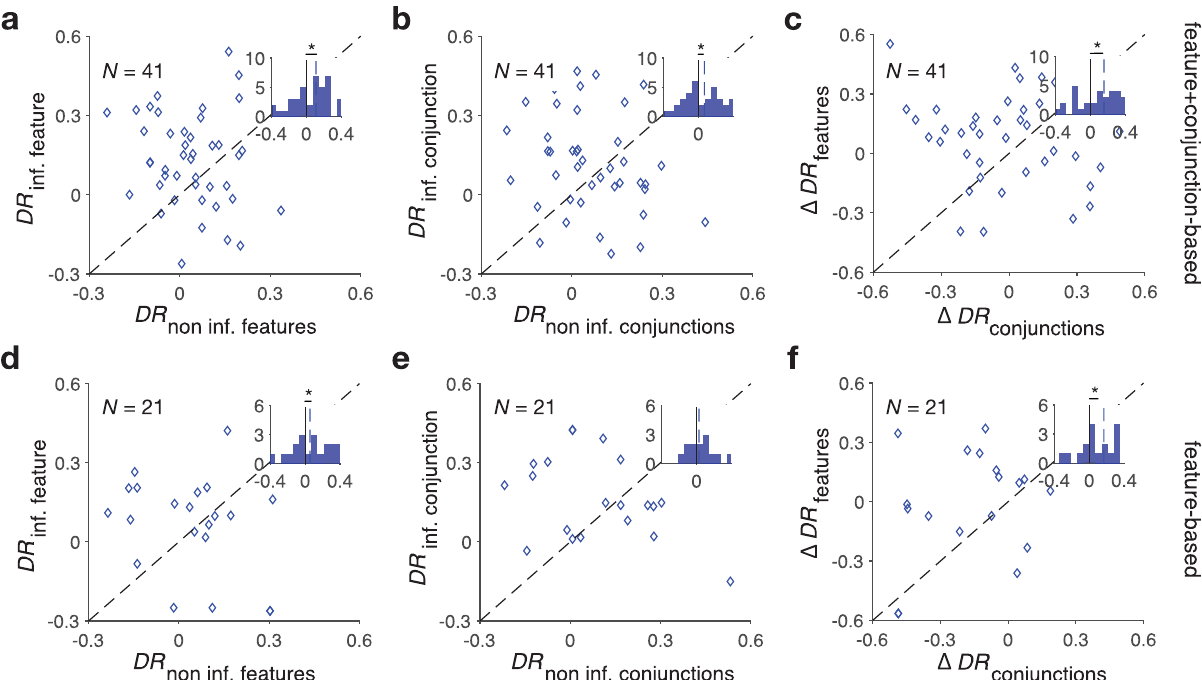
Fig. 3 Direct evidence for adoption of mixed feature- and conjunction-based learning strategy. a Plot shows differential response for the informative feature vs. differential response for the non-informative features for participants whose choice behavior was best fi t by the F + C 1 model. The inset shows the histogram of the difference between differential response of the informative and non-informative features. The dashed line shows the median values across participants, and the asterisk indicates the median is signi fi cantly different from 0 (two-sided sign-rank test; P = 0.013). b Plot shows differential response for the informative conjunction vs. differential response for the non-informative conjunctions for the same participants. The inset shows the histogram of the difference between differential response of the informative and non-informative conjunctions (two-sided sign-rank test; P = 0.031). c Plot shows the difference between differential response for the informative and non-informative features vs. the difference between differential response for the informative and non-informative conjunctions. The inset shows the histogram of the difference between the aforementioned differences (two-sided sign- rank test; P = 0.025). d – f Similar to a – c but for participants whose choice behavior was best fi t by the feature-based model (two-sided sign-rank